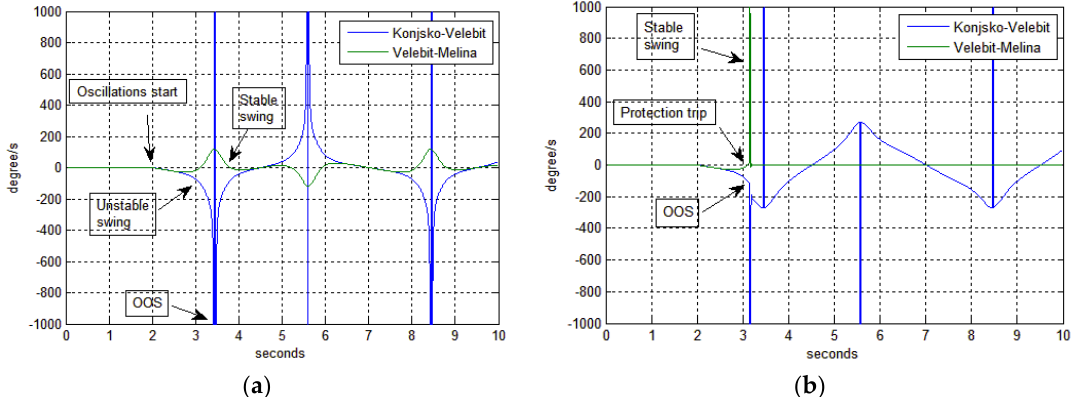
Figure 15. Active power oscillations on two 400 kV lines with angle speed ω : ( a ) On line Konjsko-Velebit there is an out-of-step (OOS) condition and on line Velebit-Melina there is a power swing condition; and, ( b ) Detail presenting angle speed ω protection operation and tripping of the Konjsko-Velebit line while linr Velebit-Melina remained in operation.